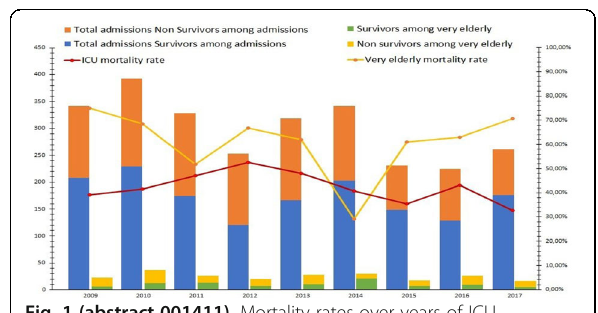
Fig. 1 (abstract 001411). Mortality rates over years of ICU admission and very elderly ICU